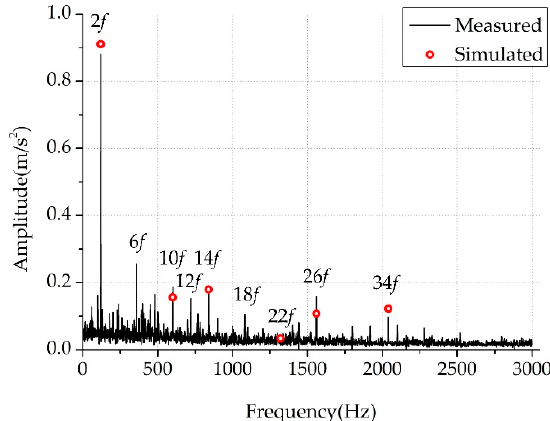
Figure 7. 10-pole 12-slot prototype acceleration spectra at 720 rpm, 26 Nm.